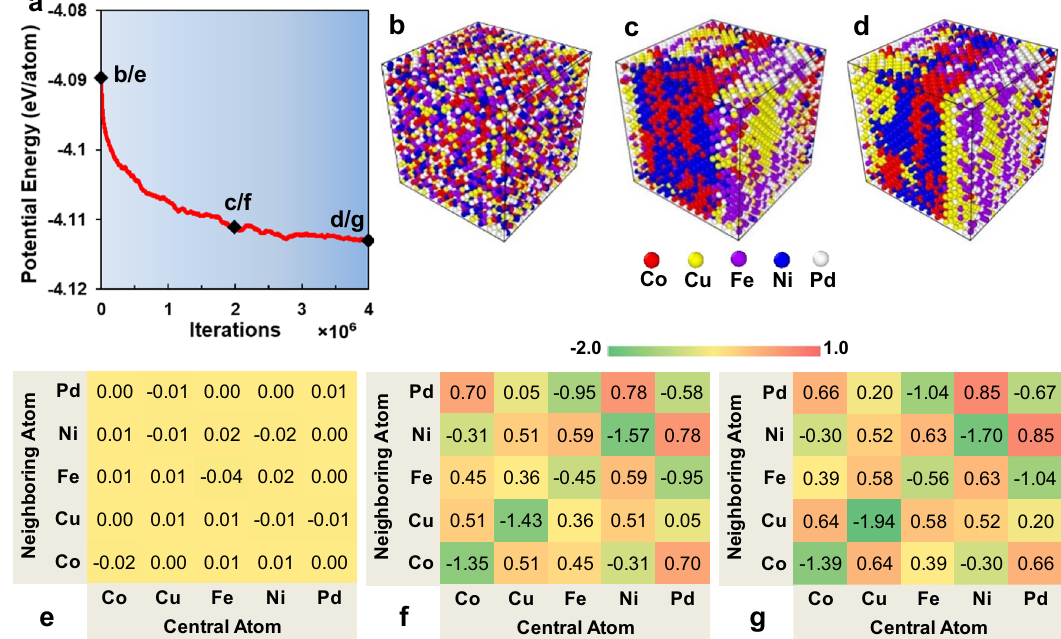
Fig. 1 Potential energy, atomic con fi gurations, and Warren-Cowley parameters of the CoCuFeNiPd HEA during iterations at 300 K. a Variation of potential energy with iterations. Atomic con fi gurations colored according to element types and tables of Warren-Cowley parameters at 0 ( b and e ), 2 × 10 6 ( c and f ), and 4 × 10 6 ( d and g ) iterations, as indicated in ( a